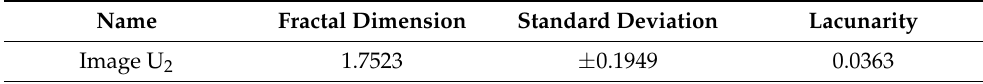
Table 2. Calculation of fractal parameters for picture U 2